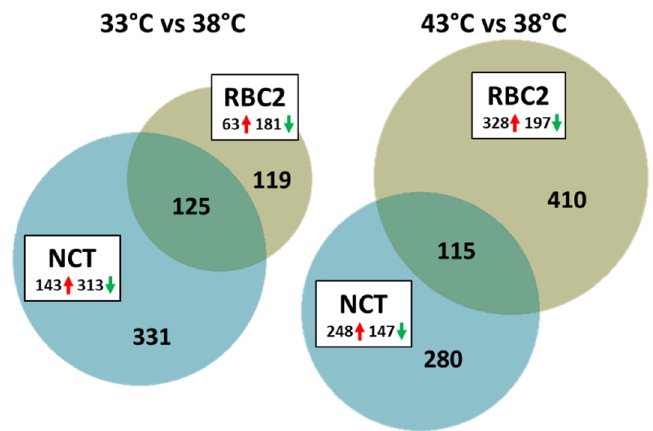
Figure 2. Distribution of differentially expressed genes during differentiation of cultured turkey p. major SCs. For each temperature comparison, the number of genes with FDR p -value < 0.05 and |Log 2 FC| > 2.0 that were shared or unique to each line (RBC2 and NCT) are indicated in the Venn diagram. Circle size is proportional to the number of DEGs. Directional expression of genes is indicated by red (up) or green (down).